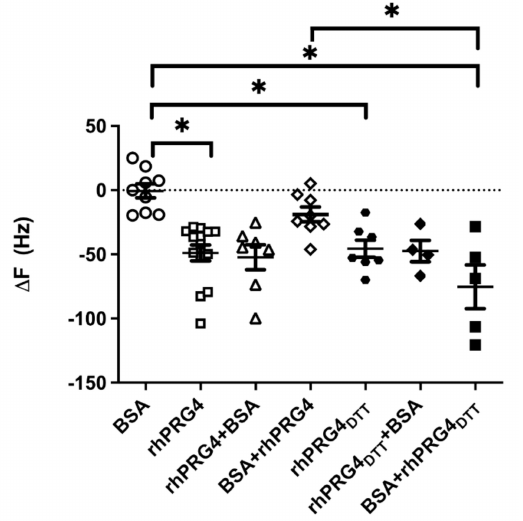
Figure 5. Anti-adhesive activity of rhPRG4 and DTT-treated rhPRG4 (rhPRG4 DTT ) in the quartz crystal microbalance. Mean ∆ F values, a measure of the amount of adsorption on the crystal surface, of BSA, rhPRG4, and rhPRG4 DTT are shown along with ∆ F measurements on surfaces coated with either rhPRG4 or rhPRG4 DTT followed by BSA or vice versa. Mean ∆ F was unaffected by BSA compared to rhPRG4 ( p < 0.05) and rhPRG4 DTT ( p < 0.05). Mean ∆ F of rhPRG4 was not significantly different from rhPRG4 DTT ( p > 0.05). Mean ∆ F of BSA on an rhPRG4 coated surface was not significantly different from rhPRG4 adsorption alone ( p > 0.05). Mean ∆ F of rhPRG4 DTT on a BSA-coated surface (BSA + rhPRG4 DTT ) was significantly lower compared to BSA ( p < 0.05). Mean ± SD displayed. * p <